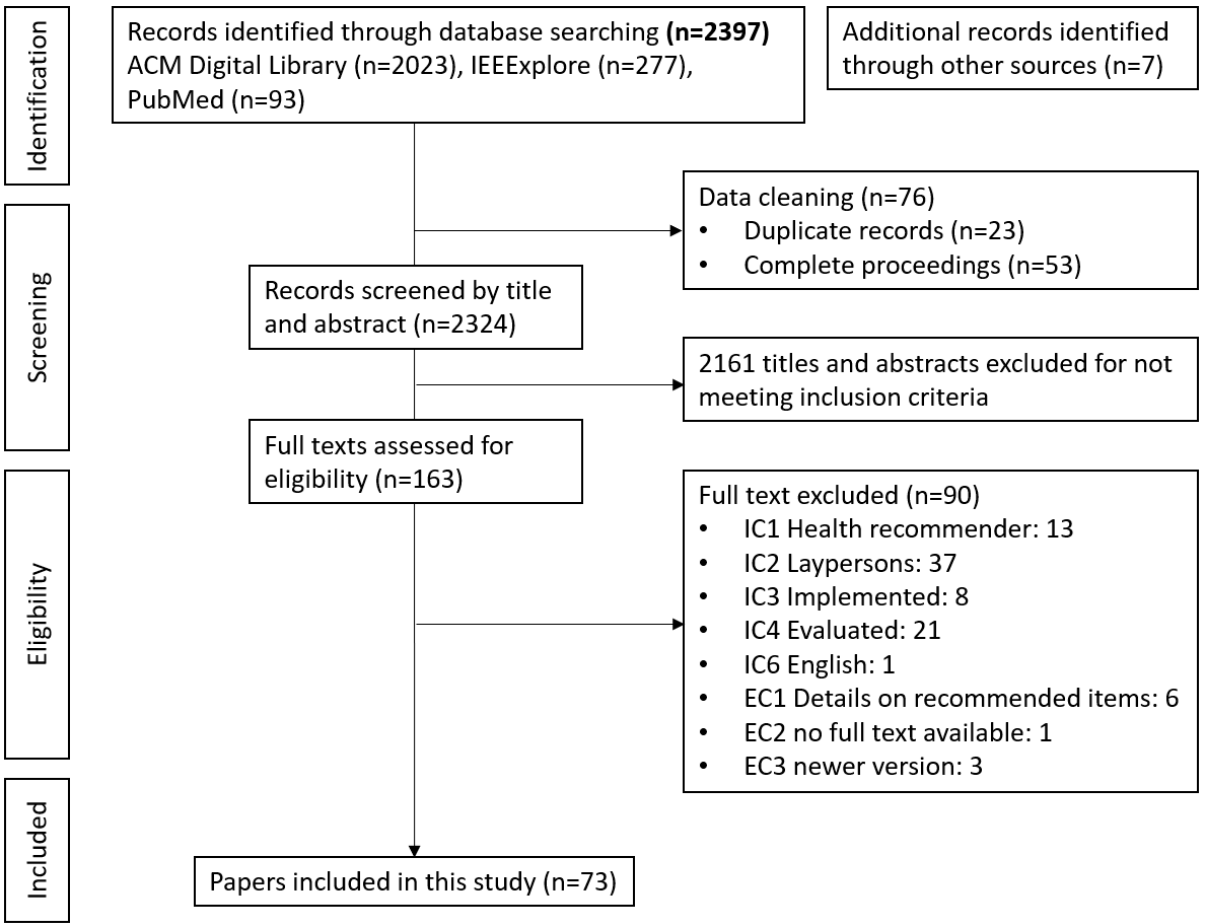
Figure 1. Flow diagram according to the PRISMA (Preferred Reporting Items for Systematic Reviews and Meta-Analyses) guidelines. EC: exclusion criteria; IC: inclusion